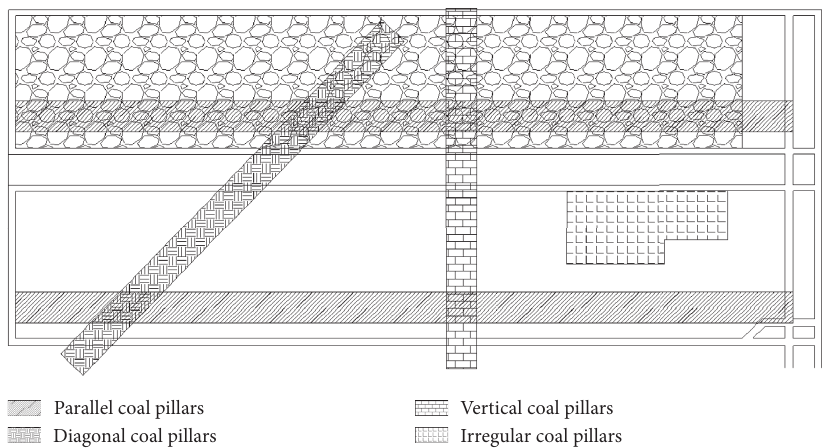
Figure 1: Spatial positional relationship diagram of overlying coal pillars and the lower working